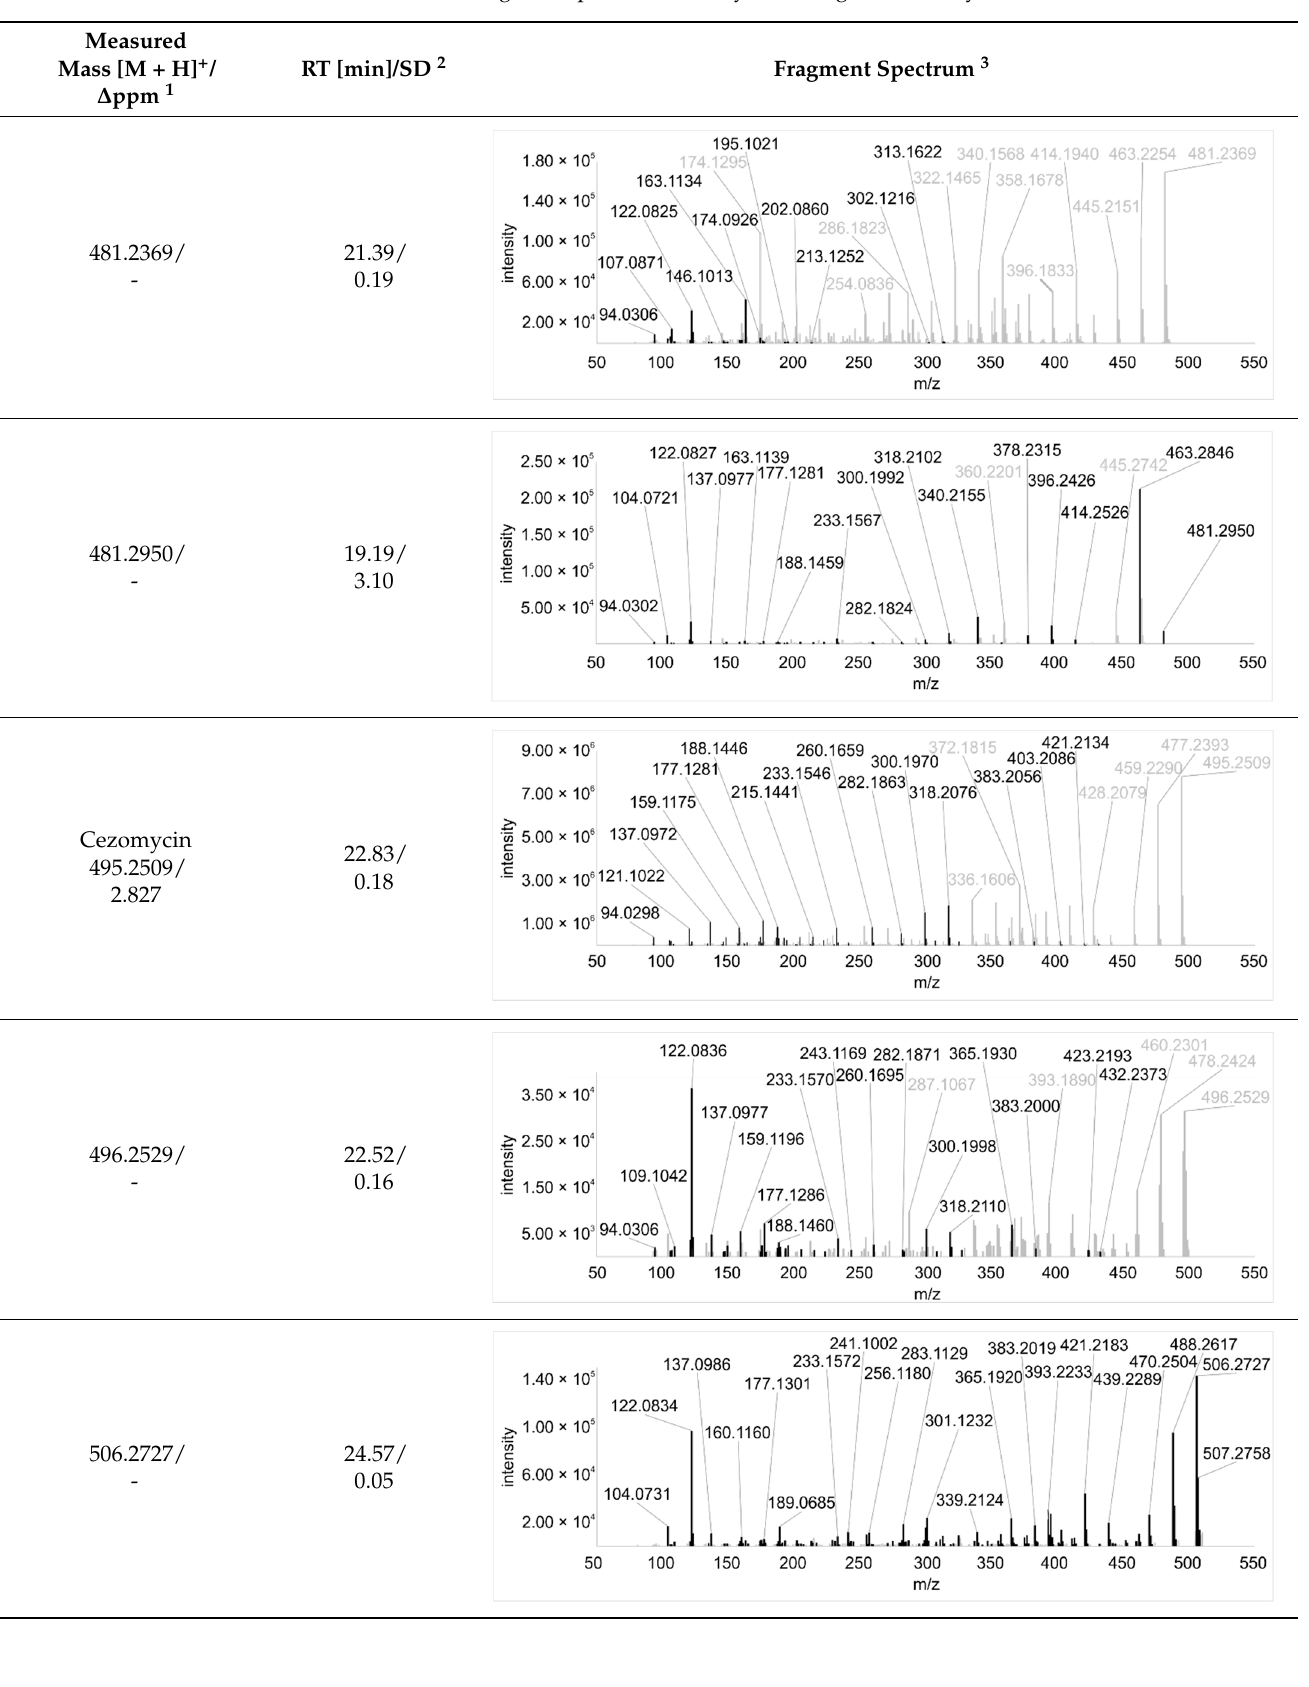
Table 2. Retention times and fragment spectra of calcimycin analogs detected by LC-MS/MS.